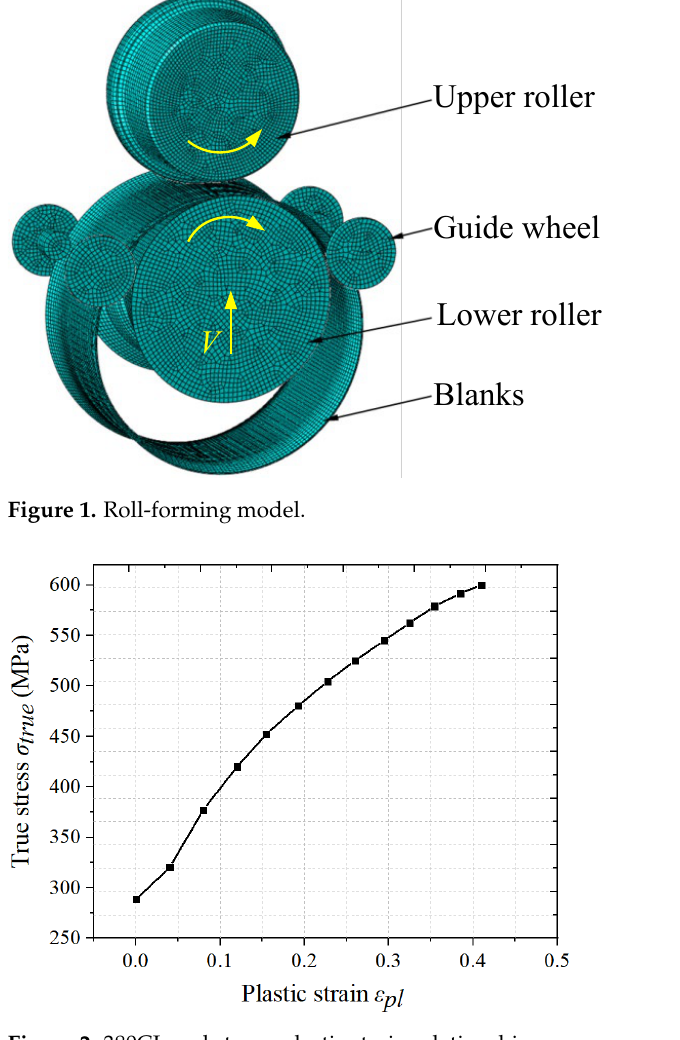
Figure 2. 380CL real stress–plastic strain relationship.